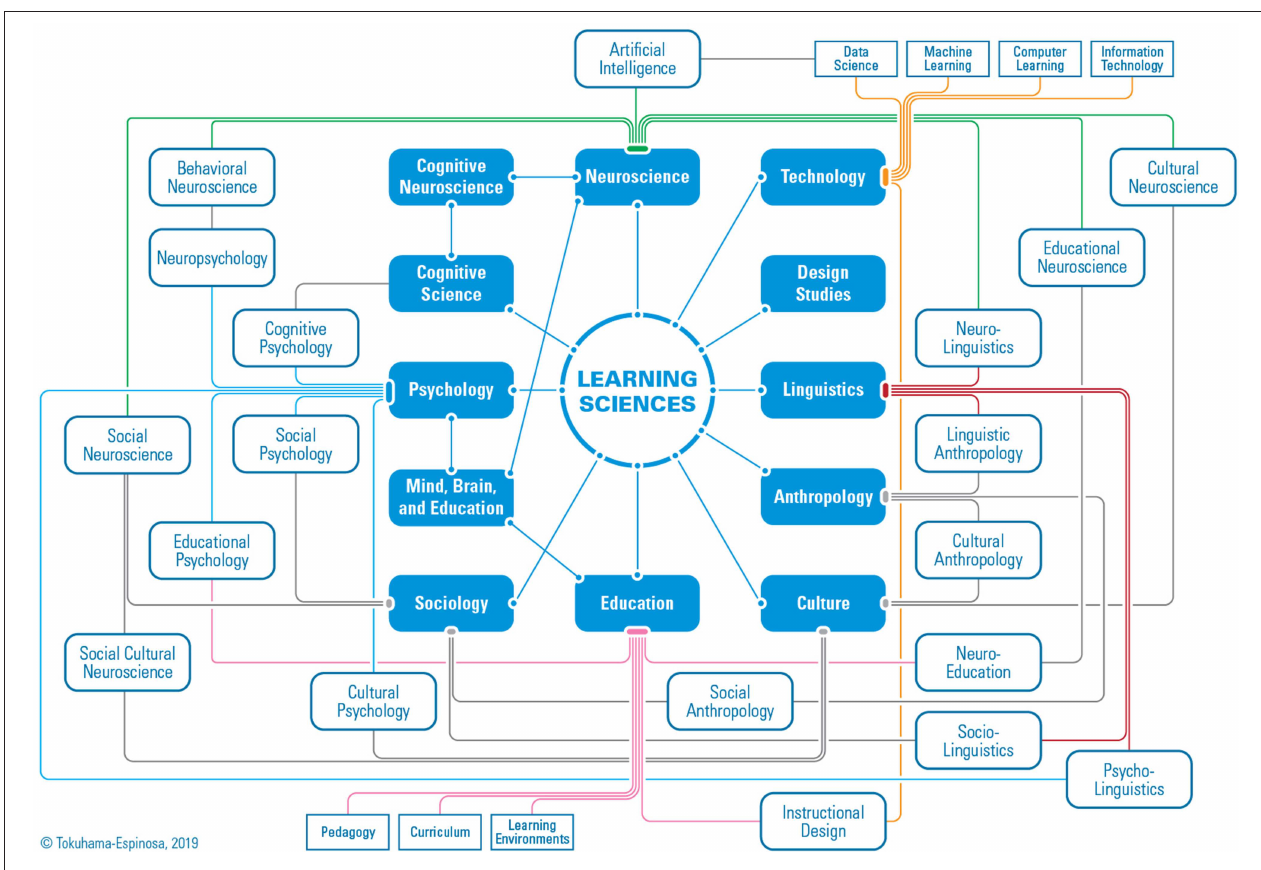
FIGURE 2 | The learning